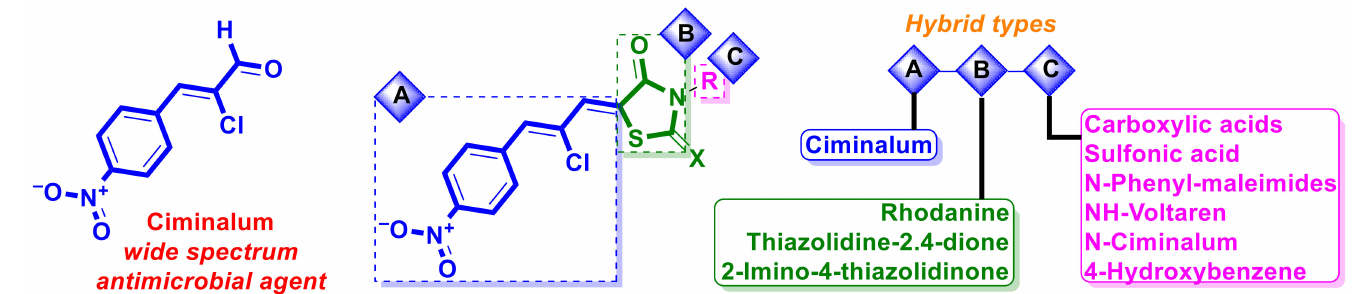
Figure 5. Structure of ciminalum and scheme of molecular hybridization strategy applied for design of potential anticancer hybrids with ciminalum moiety.